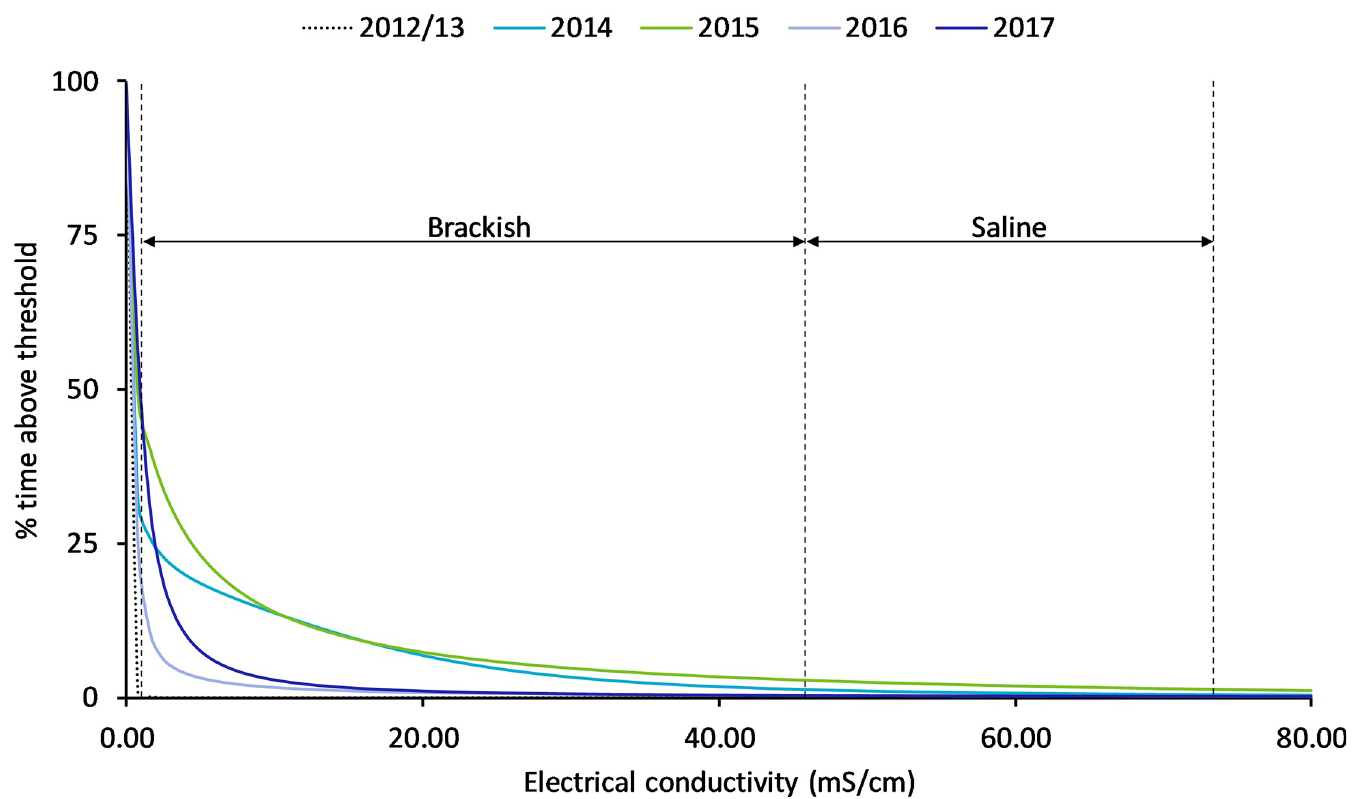
Fig 5. The percentage of time EC exceeded any given EC threshold during pre and post bund removal years within the Boolgooroo wetland. Horizontal dashed lines show boundaries between fresh, brackish, saline and briny water from left to